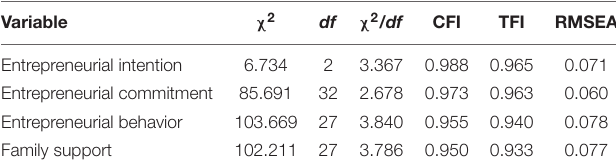
TABLE 1 | Summary of fit